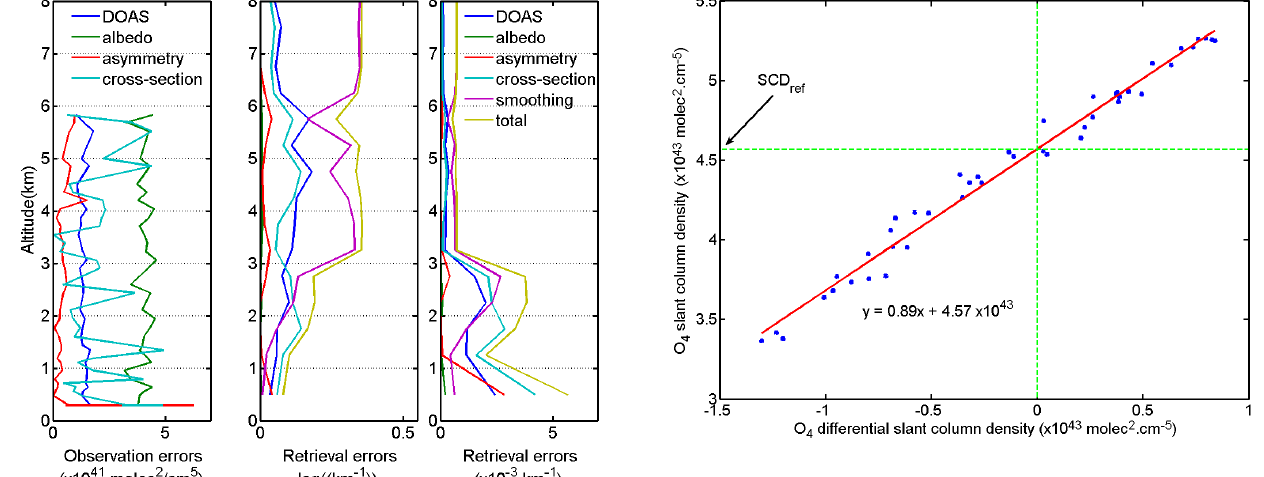
Fig. 7. Determination of the residual column density and of the O4 DSCD scaling factor. DSCD measurements at high altitude, where aerosols scattering can be neglected, are plotted versus simulated absolute SCD. The linear regression fits simultaneously the residual slant column density in the reference spectrum (the intercept, SCD ref ) and the DSCD correcting factor (the slope).